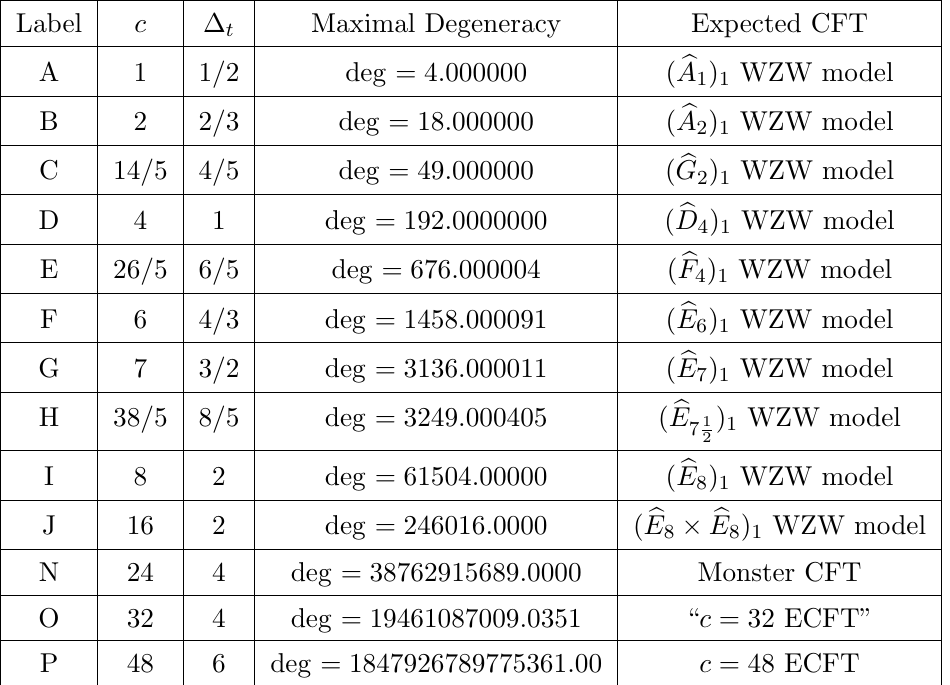
Table 3. List of theories on the numerical boundary of (cid:1) t . We include the conserved currents of j (cid:21) 1 in spectrum.